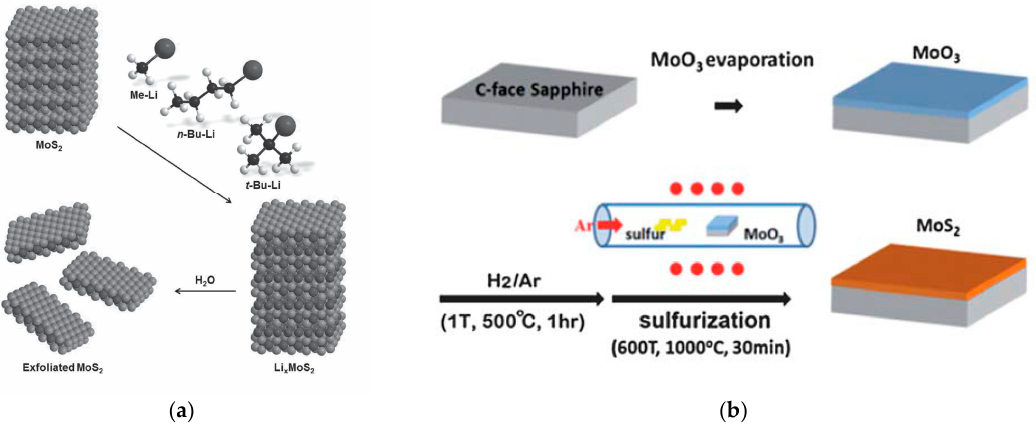
Figure 7. ( a ) Liquid exfoliation of MoS 2 by using three different compounds: methyl lithium, n -butyl lithium and tert -butyl lithium. Reprinted with permission from [37]. Copyright (2015) Wiley-VCH Verlag GmbH. ( b ) Schematic of conversion process from MoO 3 layer to MoS 2 . Reprinted with permission from [41]. Copyright (2012) The Royal Society of Chemistry.